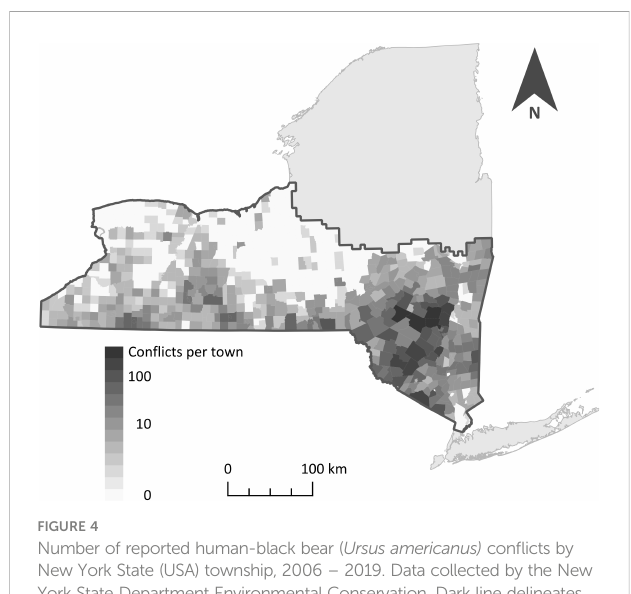
FIGURE 4 Number of reported human-black bear ( Ursus americanus) con fl icts by New York State (USA) township, 2006 – 2019. Data collected by the New York State Department Environmental Conservation. Dark line delineates the study area perimeter. Darker shading indicates higher density of con fl ict